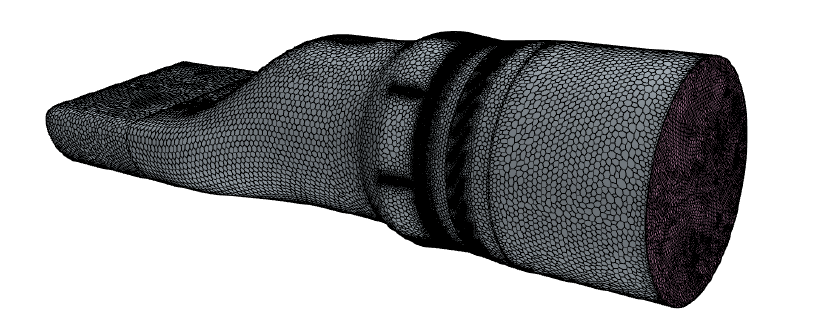
Figure 4. Global external surface reference mesh (75M elements).